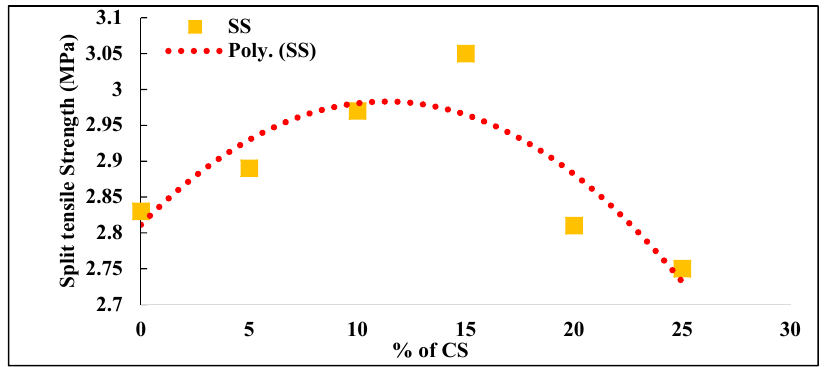
Figure 5. Split tensile strength of CS concrete.